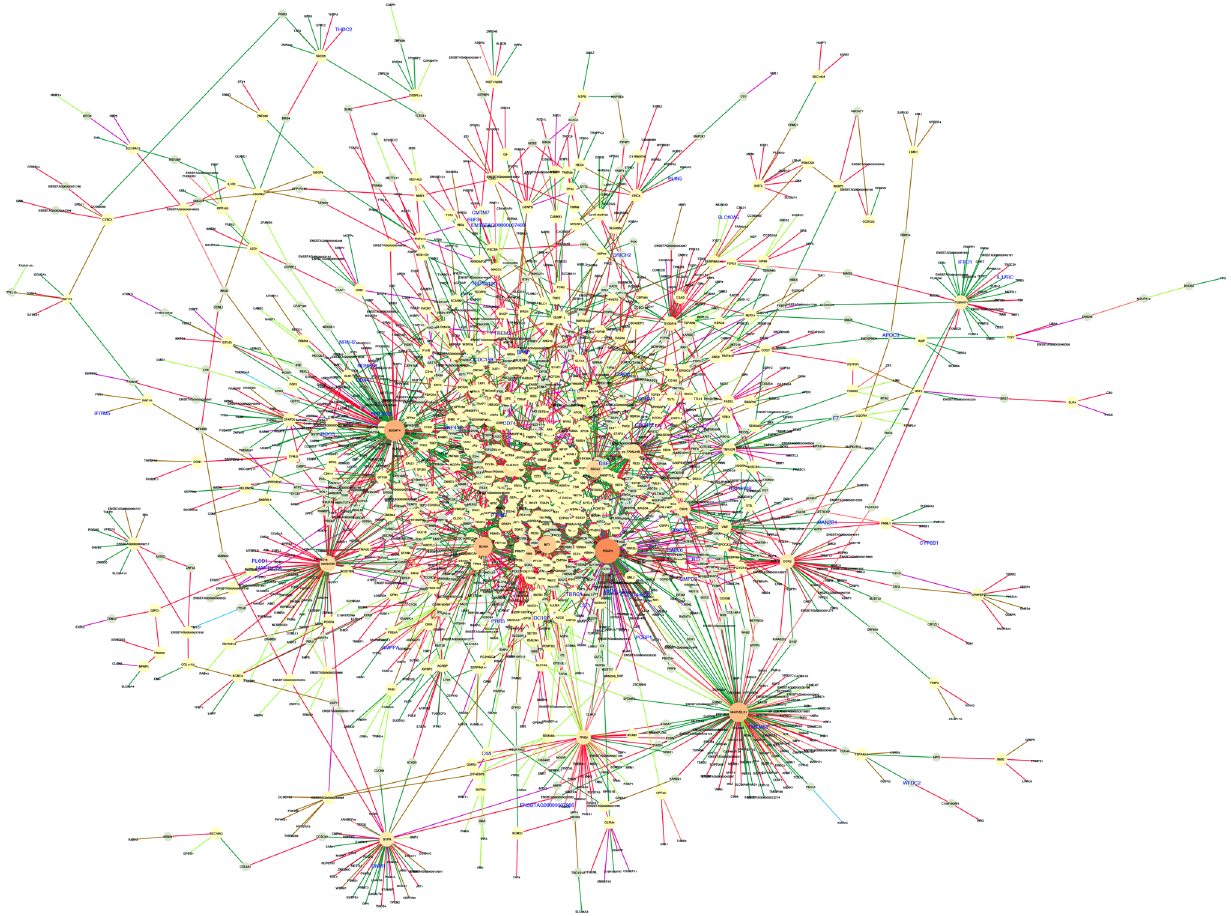
Figure 5. Liver regulatory network of differentially co-expressed genes from the bovine transcriptome. Nodes are genes with significant changes in the correlation between control and nutrient restricted fetus ( q ≤ 0.05). The node size and color (from light to dark) are proportional to the number of connections for each gene. Nodes with few connections not linked to the main network are not showed. Transcription factors are represented by a diamond shape. Differentially expressed genes are labeled in blue. Edges are colored based on the differential correlation class (+/− , red; + /0, salmon; − /+ , green; − /0, green-yellow; 0/+ , magenta; 0/− , brown). Gene network was created on Cytoscape v.3.7 89